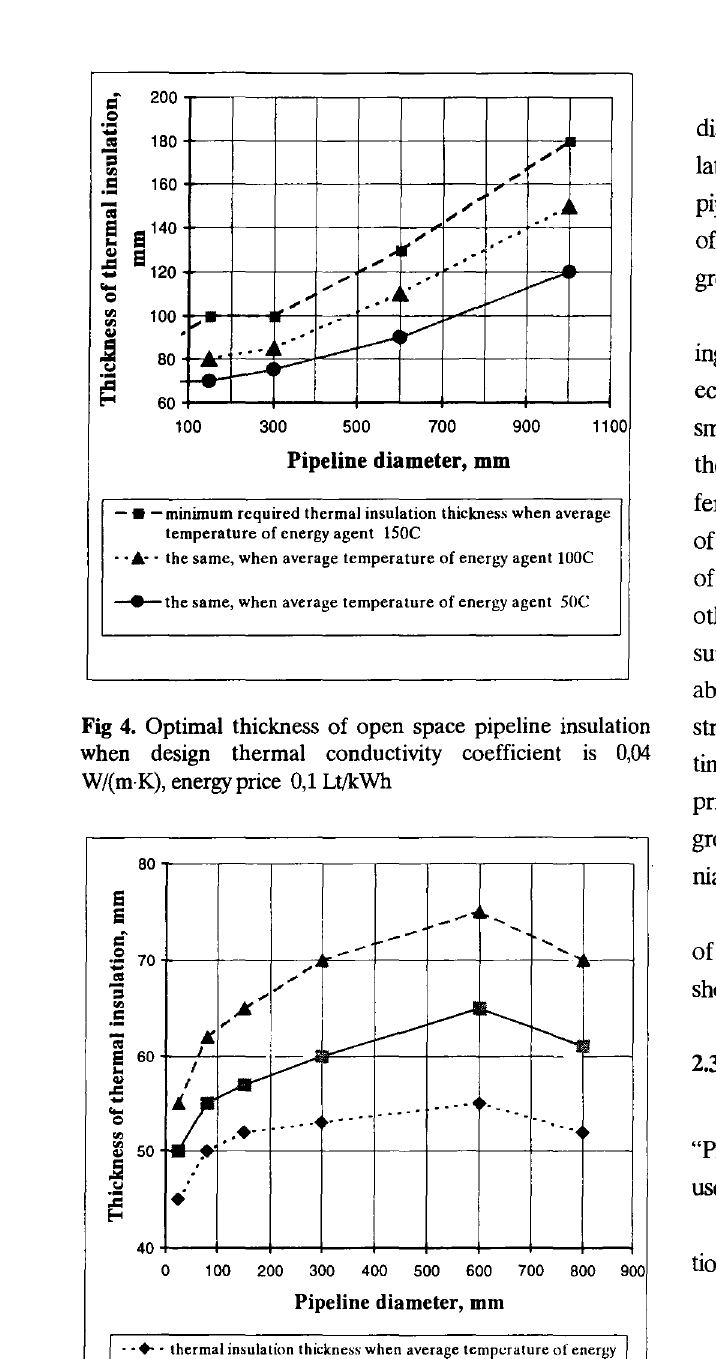
Fig 5. Optimal insulation thickness for underground pipe line without channel when design thermal conductivity co efficient is 0,031 W/(m-K), energy price 0,1 Lt/kWh